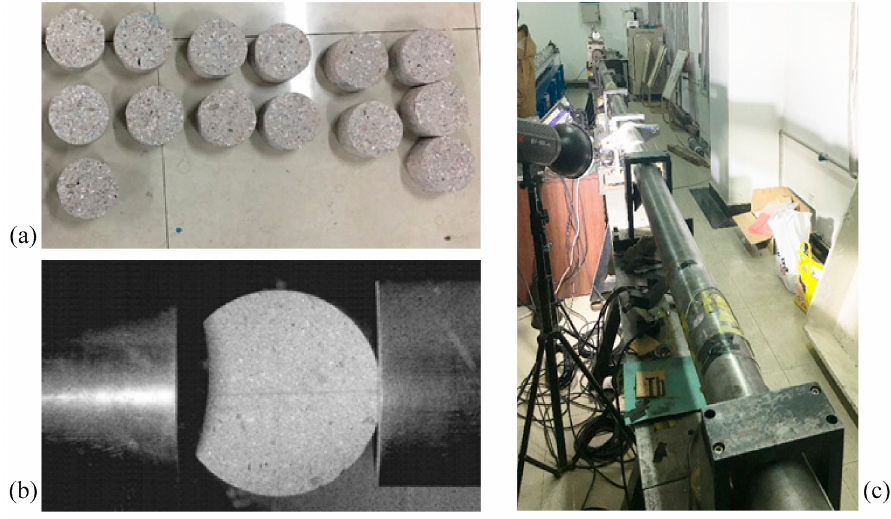
Figure 3. ( a ) Concrete specimen; ( b ) specimen setup; ( c ) incident bar and transmission bar.